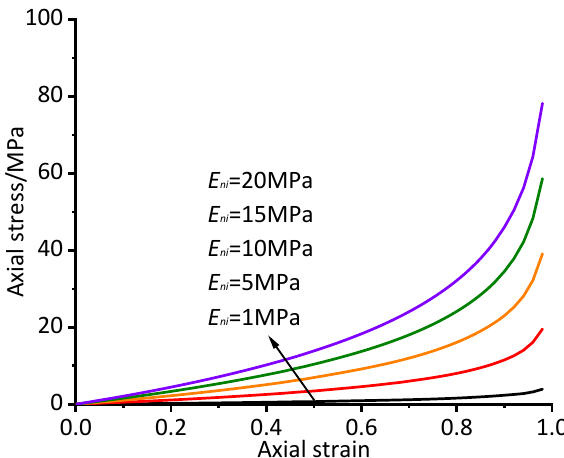
Figure 4. Stress ‒ strain curves for different E ni values ( m = 1.0). Figure 4. Stress-strain curves for different E ni values ( m = 1.0).